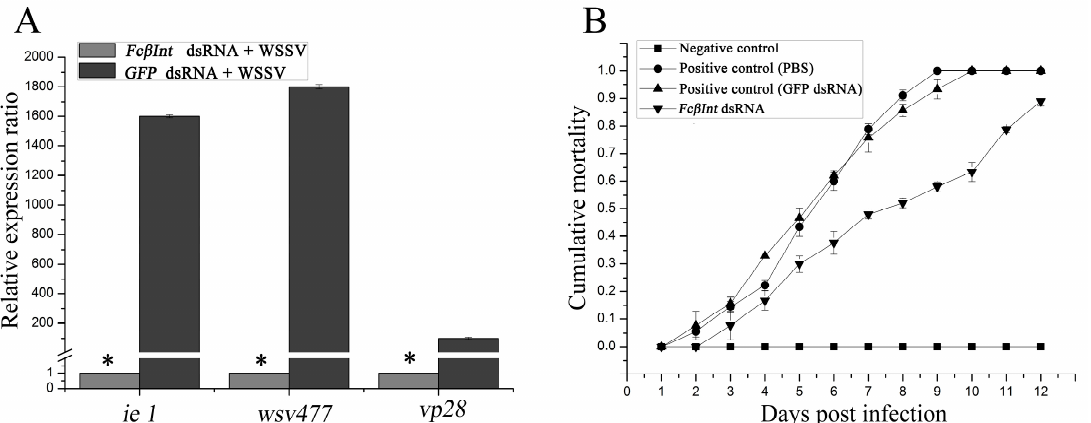
Figure 7. Influence of dsRNA-mediated Fc β Int silence on WSSV genes expression in hemocytes ( A ) and mortalities of viral-challenged shrimp ( B ). Significant differences ( p < 0.05) are marked with an asterisk. The bar represents the SD of the mean ( n = 3).